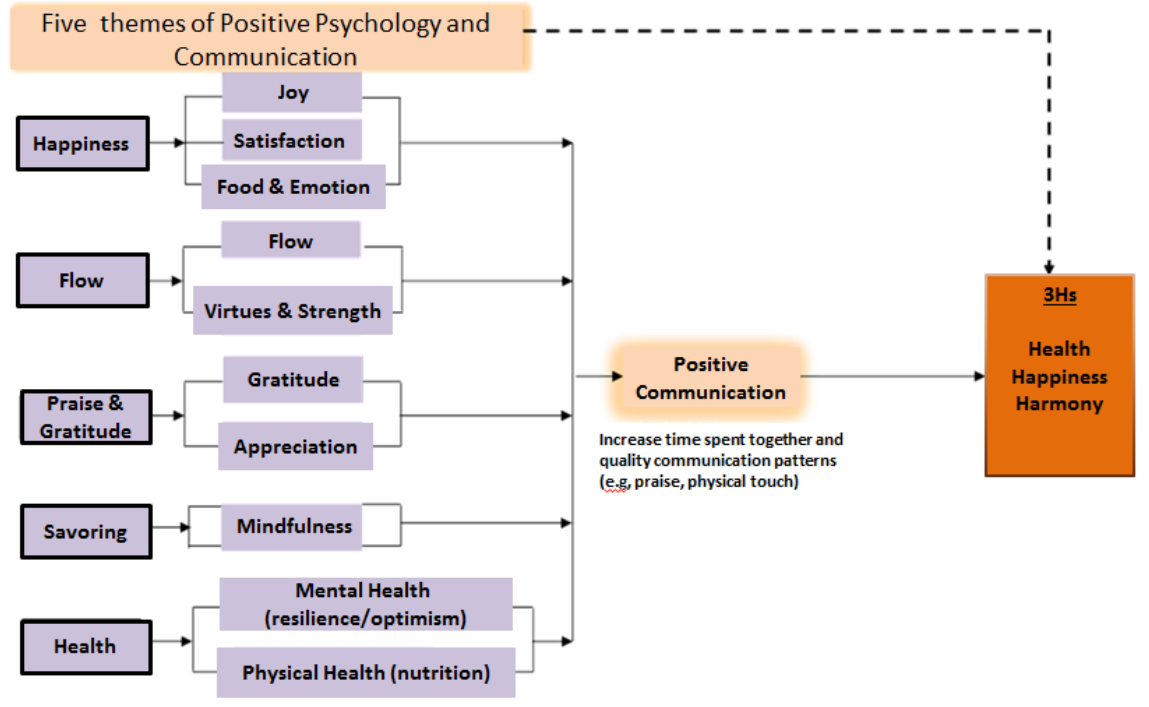
Figure 1. Conceptual framework of the Happy Family Kitchen intervention